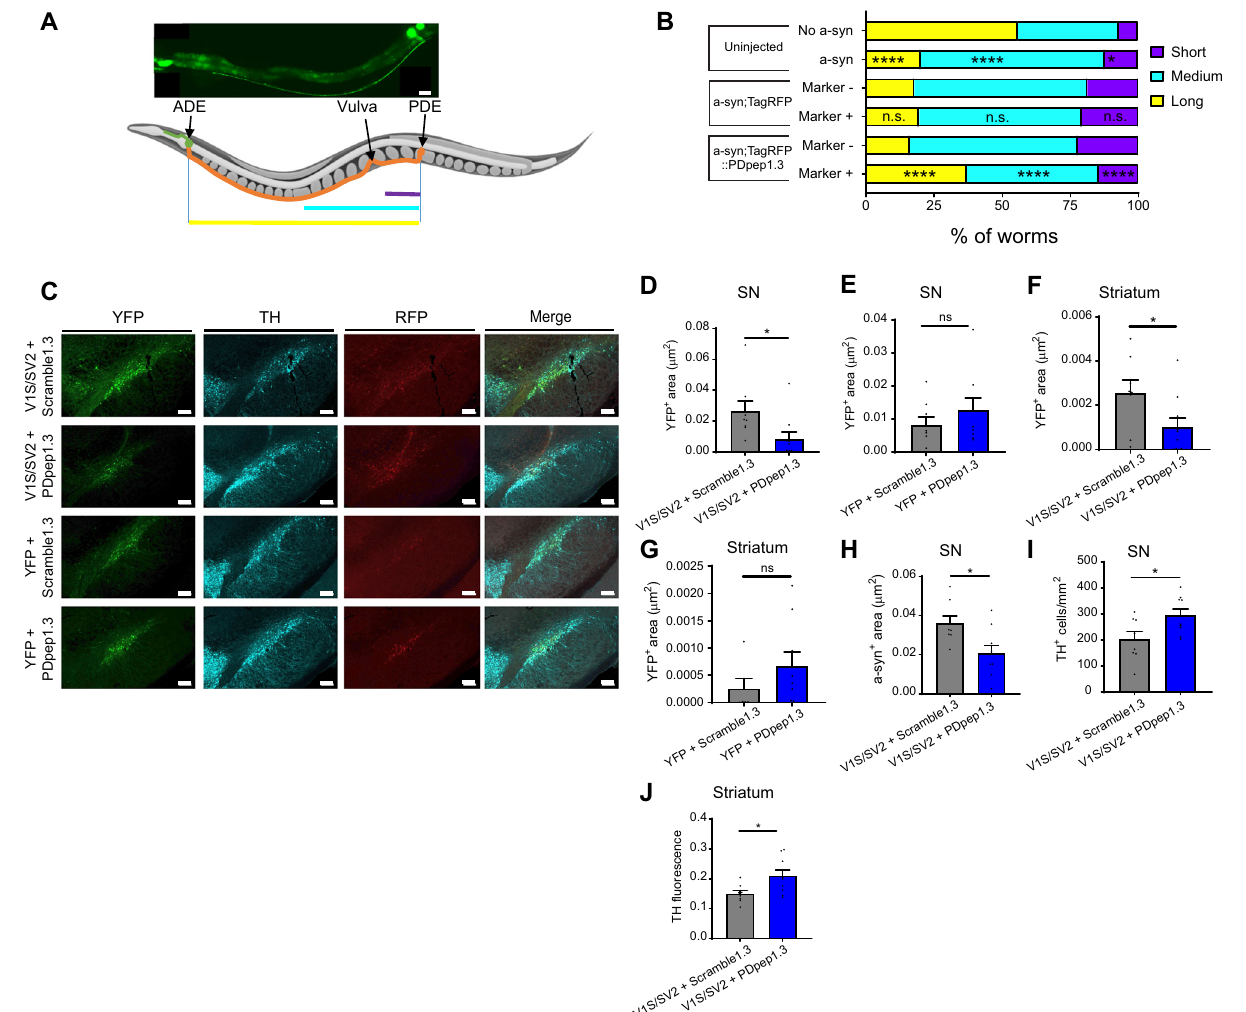
Fig. 4 | PDpep1.3 reduces a-syn-mediated neurodegeneration in C. elegans and an a-syn oligomer rat model. A Representative image of an adult C. elegans with PDE neuron visualized using dat-1p::gfp ( egIs1 ) (scale bar=20 μ m) (top panel). Neurite length for each PDE neuron was categorized as: Short (does not extend pastthevulva;purple),Medium(extendspastthevulvabutnotbeyondhalfwayto ADE neuron; cyan), or Long (extends to ADE neuron; yellow) (created using an image from somersault1824 at https://somersault1824.gumroad.com/). B FrequenciesofPDEneurite lengthswerecomparedfor C.elegans expressing no a-syn versus a-syn alone (Pearson Chi-Square test, χ 2 (2, 1252)=169.0; P <0.0001), a-syn with RFP (a-syn;TagRFP Marker+) versus a-syn without RFP (a-syn;TagRFP Marker-) (Pearson Chi-Square test, χ 2 (2, 910)=1.332; P =0.5137), and a-syn with RFP-PDpep1.3 (a-syn;TagRFP::PDpep1.3 Marker+) versus a-syn without RFP- PDpep1.3(a-syn;TagRFP::PDpep1.3Marker-)(PearsonChi-Squaretest, χ 2 (2,1528)= 86.1729; P <0.0001). C Representativeimagesofnative YFP andRFP fl uorescence and immunostaining with anti-tyrosine hydroxylase (TH) antibody in substantia nigra (SN) of rats injected with V1S/SV2 or YFP plus Scramble1.3-RFP